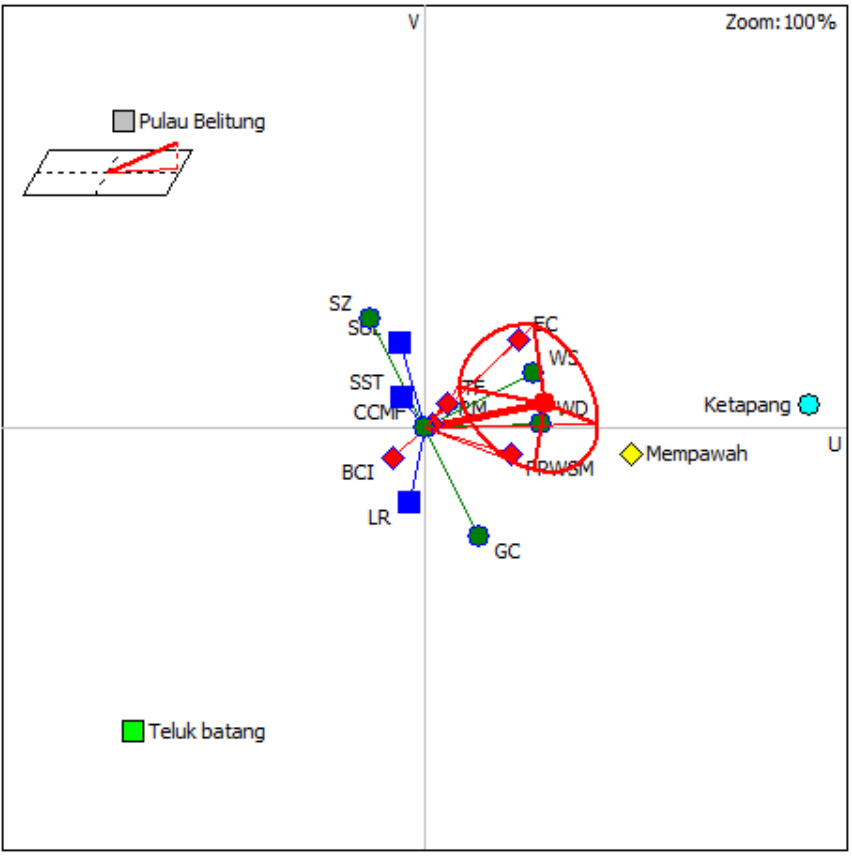
Figure 6. Alternatives and criteria in the GAIA plane.